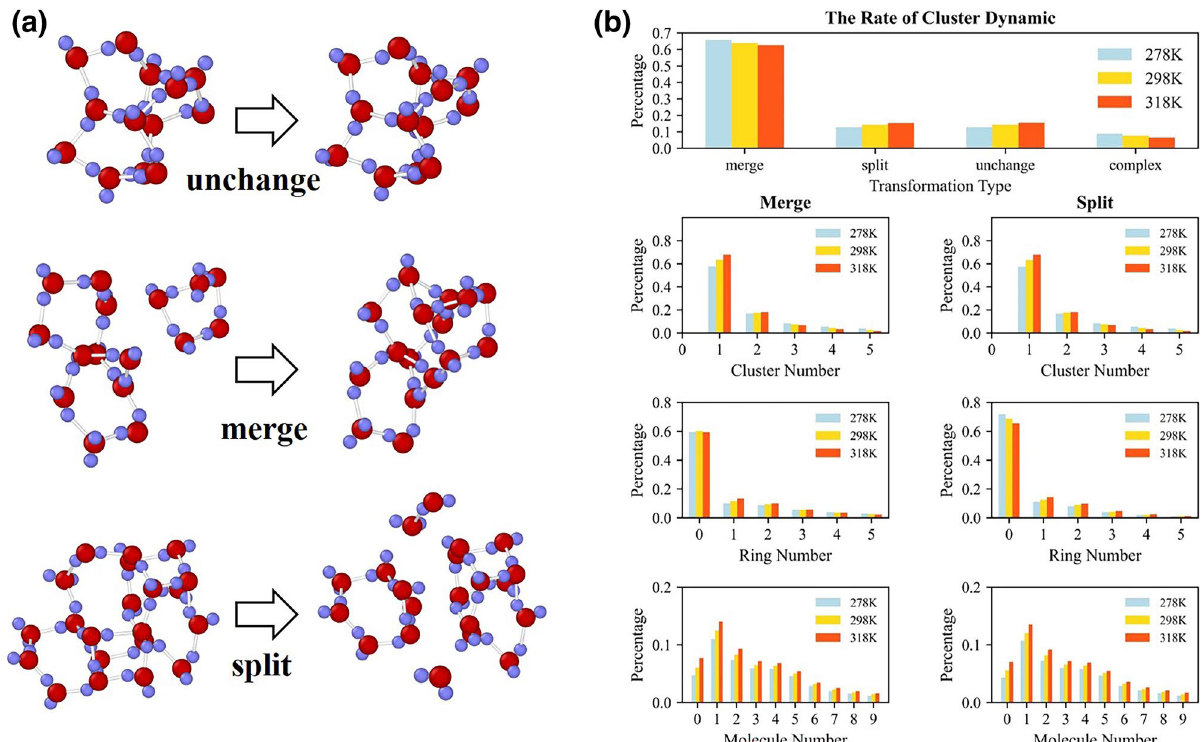
Figure 4. Example of cluster transformation and the distribution of cluster transformation at various temperatures. ( a ) Some example of cluster transformation involving unchanged, merged and split at 298 K drawn by Ovito 58 . ( b ) The rate of cluster transformation and the products or reactant distributions of cluster splitting and merging at 278 K, 298 K and 318